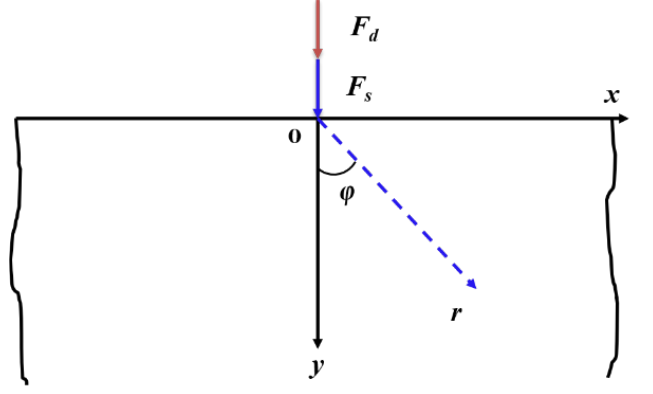
Figure 1. Schematic diagram of harmonic vibration impacting an infinite stratum.